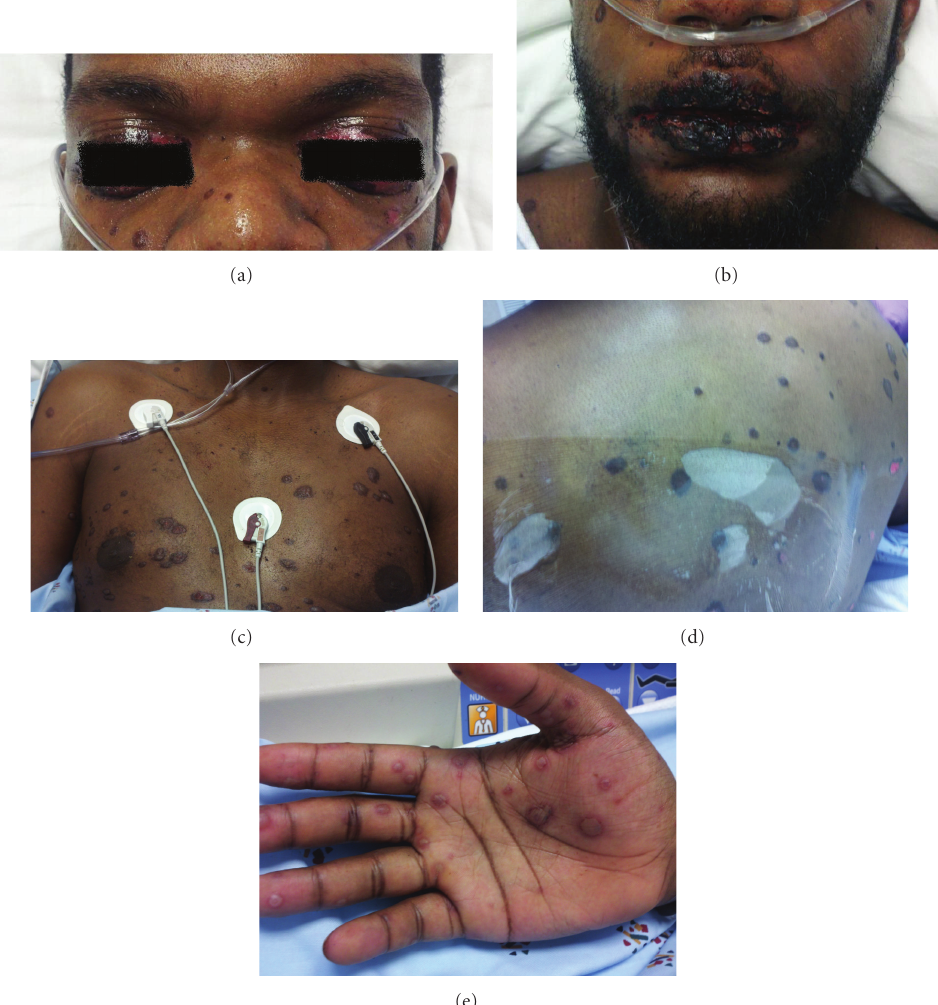
Figure 1: (a) Swelling and necrosis of eyelids with conjunctival erythema. (b) Severe necrosis of oral mucosa. (c) Macules and patches on chest. (d) Rash on back with areas of necrosis and denudation. (e) Targetoid lesions on right palm.